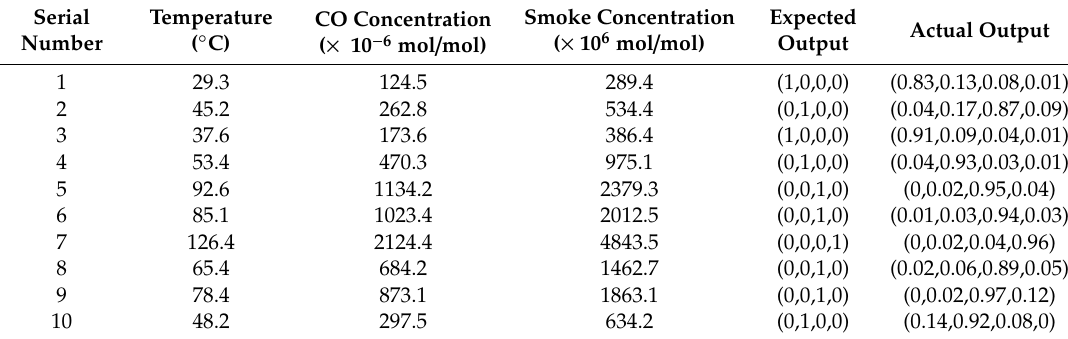
Table 3. Test sample data and test results